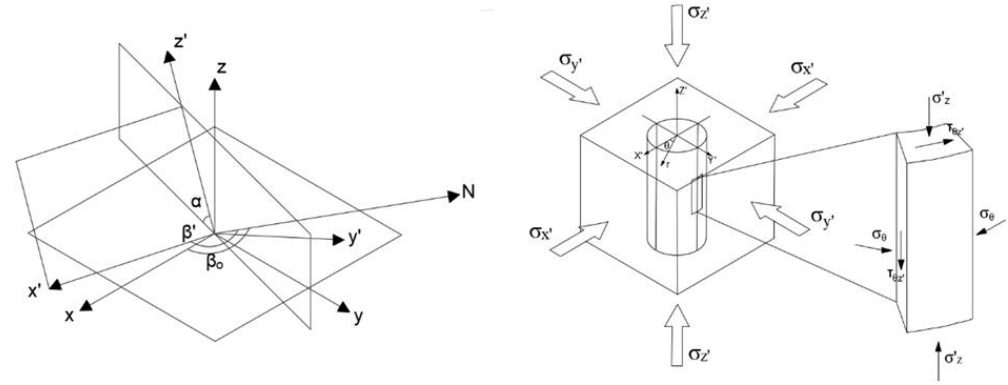
Figure 7. A diagram of the spatial relationship of the coordinate system.